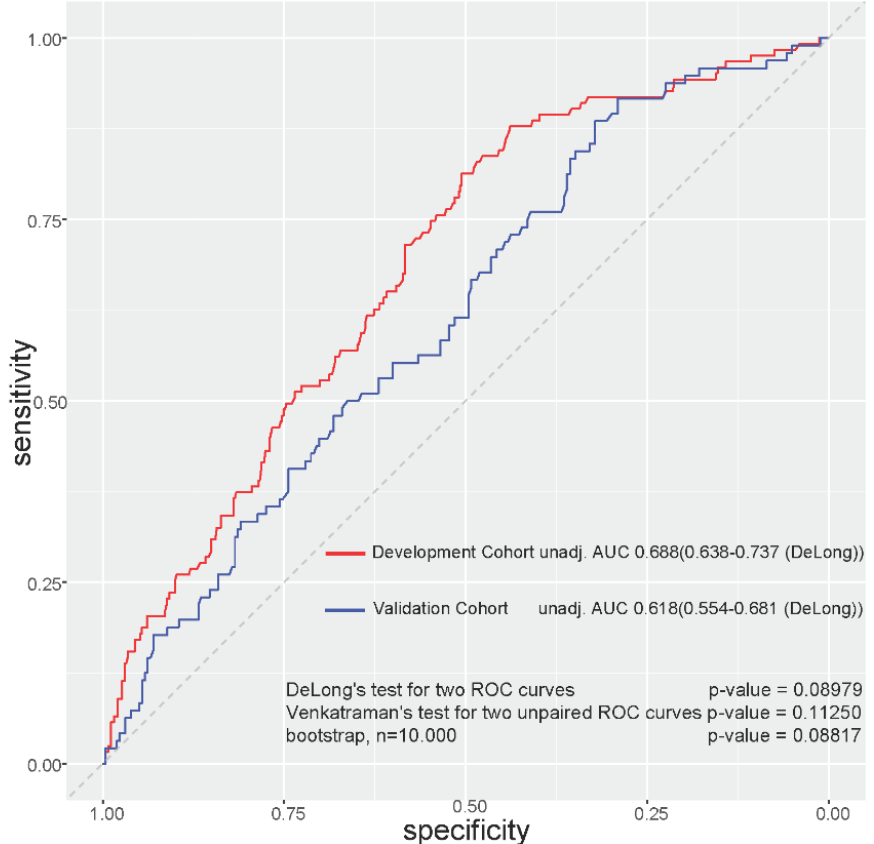
Figure 3 . Discrimination ability of the final model in the development cohort and in the validation cohort. Discrimination ability between cohorts was compared using the DeLong nonparametric test, the Venkatraman test for two unpaired ROC curves, and by bootstrapping.